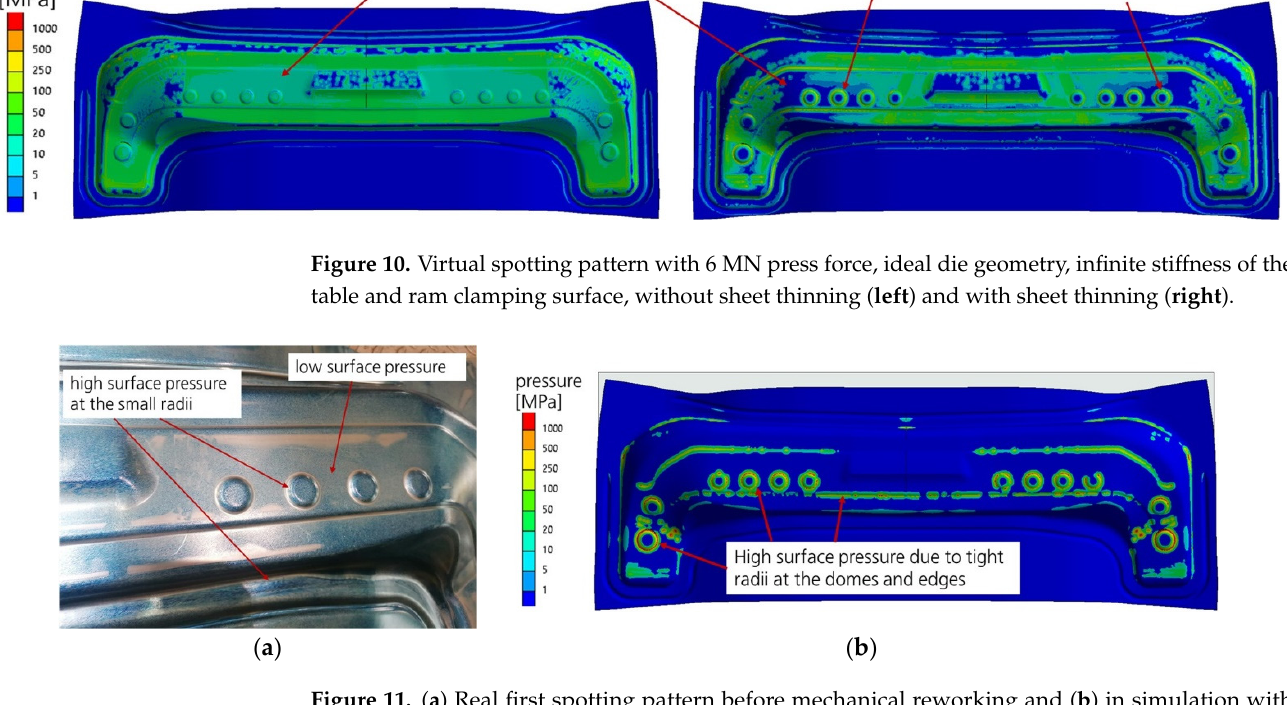
8 of 10 Figure 9. FE model for calculation of virtual spotting pattern, including formed workpiece. 4.3. Reference Simulation as State of the Art and Influence of Sheet Thinning A reference scenario is given by state-of-the-art simulations in the industry, where rigid clamping surfaces are common and the elasticity of the forming tool is covered in-